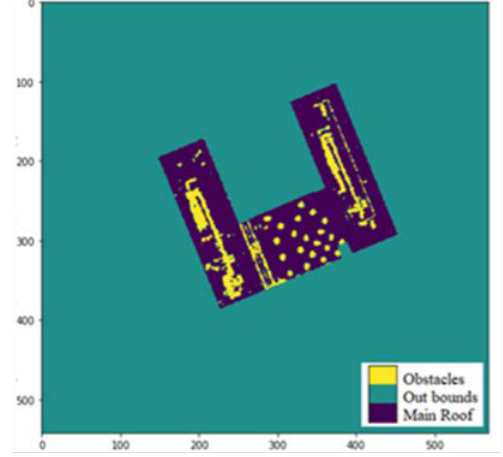
Figure 2 . Unsupervised classification result in three classes